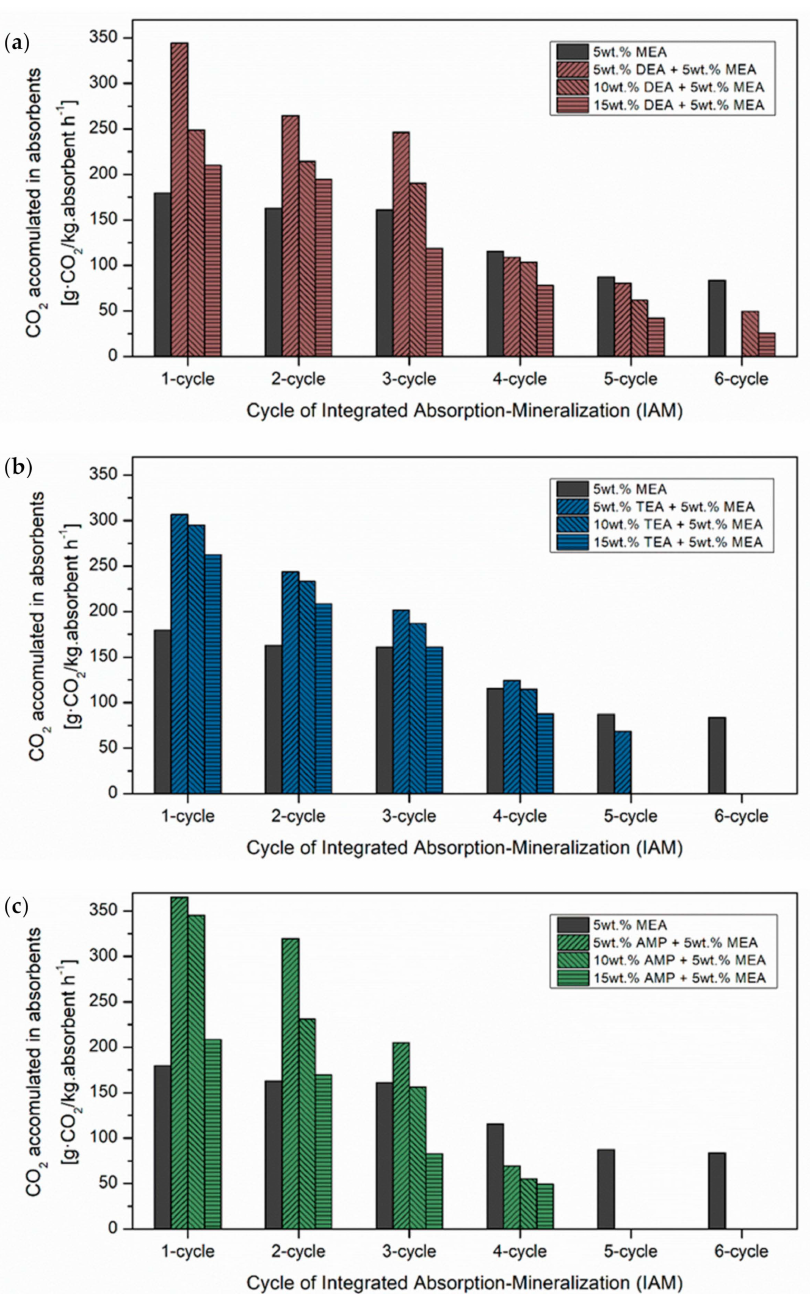
Figure 2. The CO 2 accumulation in the blended alkanolamine absorbents in each cycle of the multicycle integrated absorption–mineralization (IAM) was evaluated as a function of the absorption time for monoethanolamine (MEA)-blended ( a ) diethanolamine (DEA), ( b ) triethanolamine (TEA), and ( c ) aminomethyl propanol